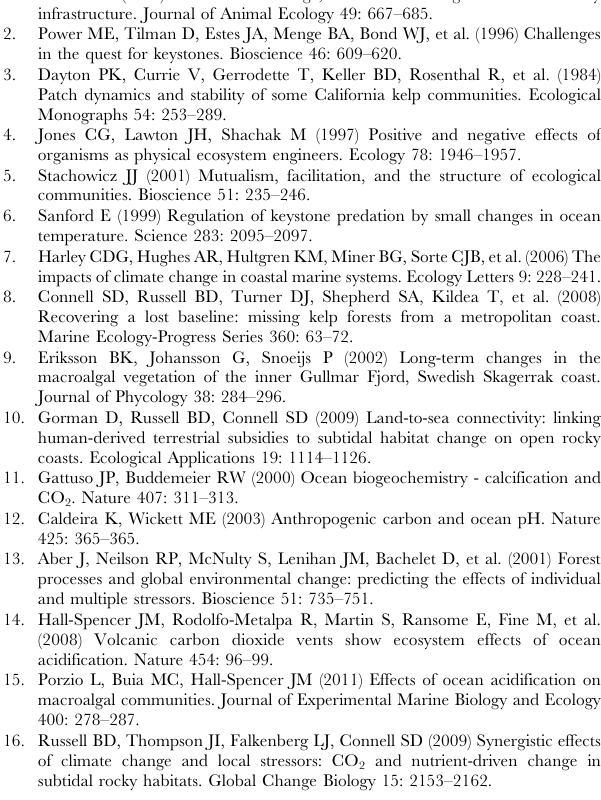
maximum and minimum values. Field ammonia, phosphate and NO X were sampled weekly on six occasions, with laboratory-based mesocosms sampled on alternate days ( n =20 occasions). Total Alkalinity (TA), pH and temperature were simultaneously measured weekly on eight occasions, from which concentrations of p CO 2 (ppm) and bicarbonate (HCO 3 2 ) ( m mol kg 2 1 ) were calculated using constants from Mehrbach et al. [28], as adjusted by Dickson and Millero [29]. Light was measured on one occasion. (TIF) Table S5 Results from ANOVA, testing the combined effect of Kelp (present v. absent), Nutrients (ambient v. elevated) and CO 2 (current v. future) on the 9 physico- chemical parameters measured in the field and effect of Nutrients (ambient v. elevated) on the 3 measured in the laboratory. Field ammonia, phosphate and NO X were sampled weekly on six occasions, with laboratory-based mesocosms sampled on alternate days ( n = 20 occasions). Total Alkalinity (TA), pH and temperature were simultaneously measured weekly on eight occasions, from which concentrations of p CO 2 (ppm) and from Mehrbach et al. [28], as adjusted by Dickson and Millero [29]. Light was measured on one occasion. Figure S1 Nutrient concentrations within field (a, c, e) and laboratory (b, d, f) based mesocosms measured from beginning to end of the experiment. Ammonia (a, b), phosphate (c, d) and NO X (e, f ) under ambient nutrients (filled circles) and elevated nutrients (empty circles). Data presented are means across CO 2 and kelp treatments. Note the different scales on the y-axes. (TIF)